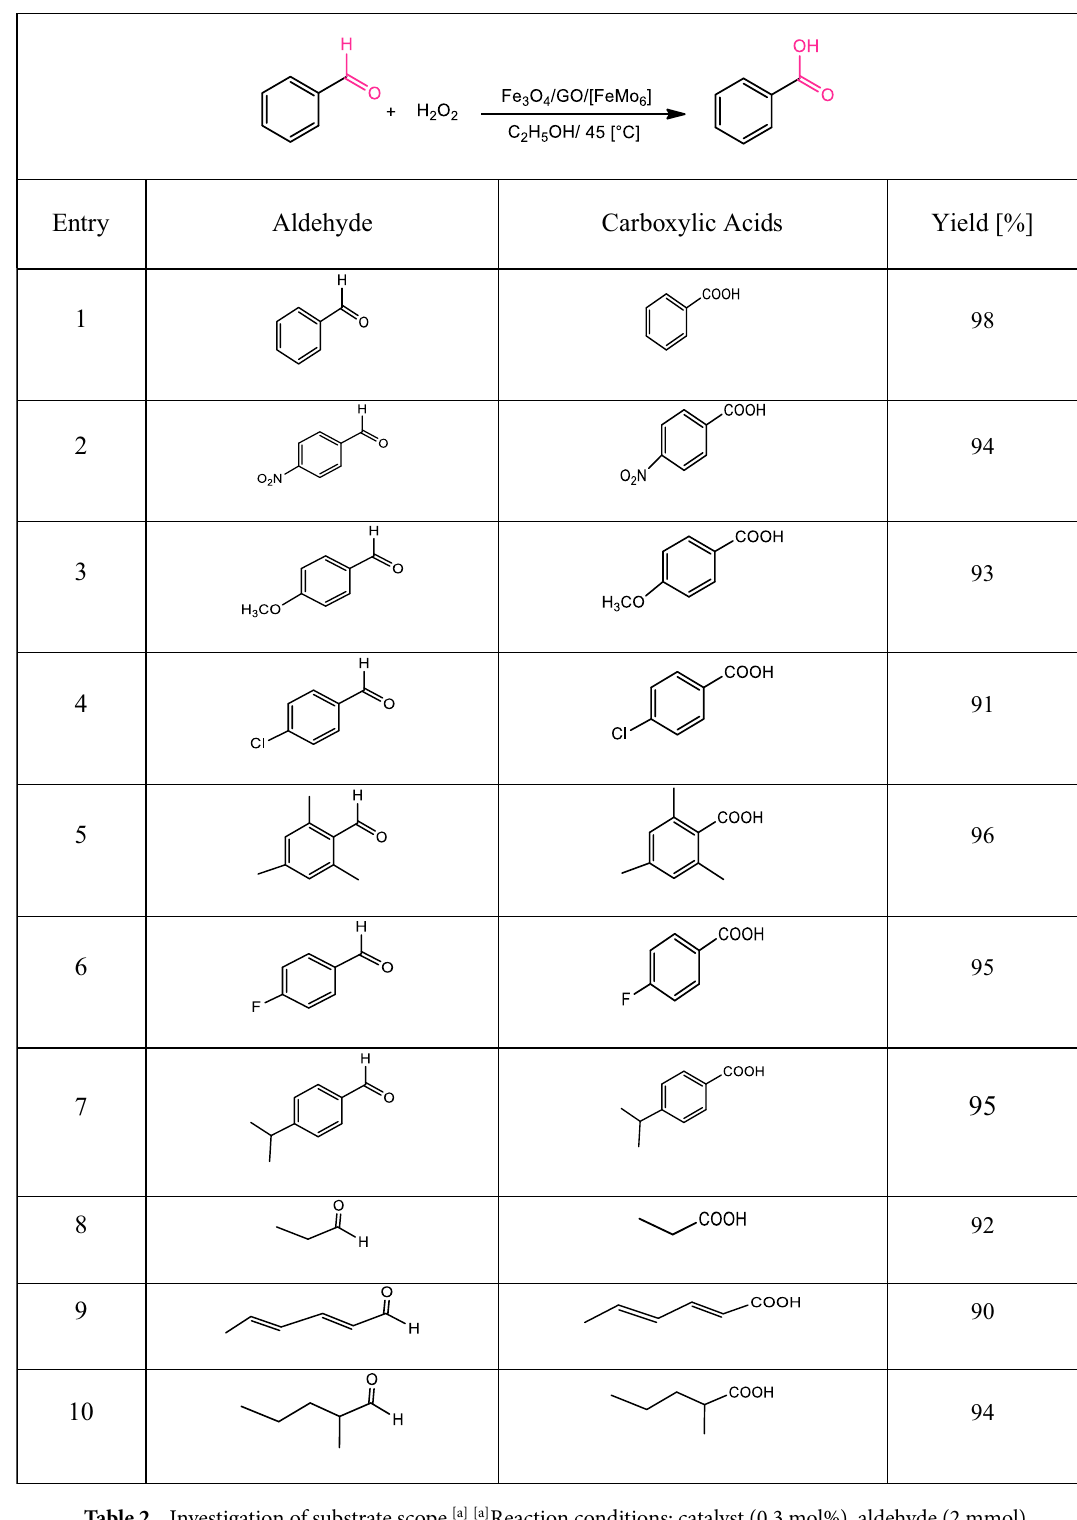
Table 2. Investigation of substrate scope. [a] [a] Reaction conditions: catalyst (0.3 mol%), aldehyde (2